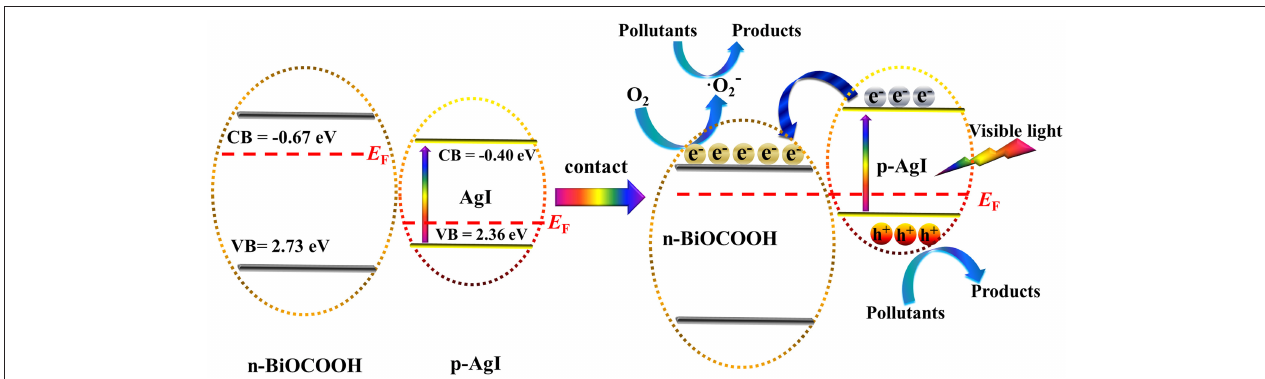
FIGURE 9 | Proposed mechanism of pollutant degradation over AgI/BiOCOOH under visible